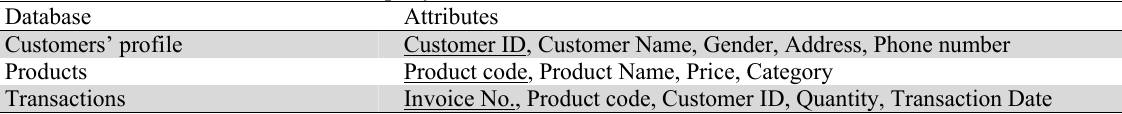
Attributes of the databases of the company Database